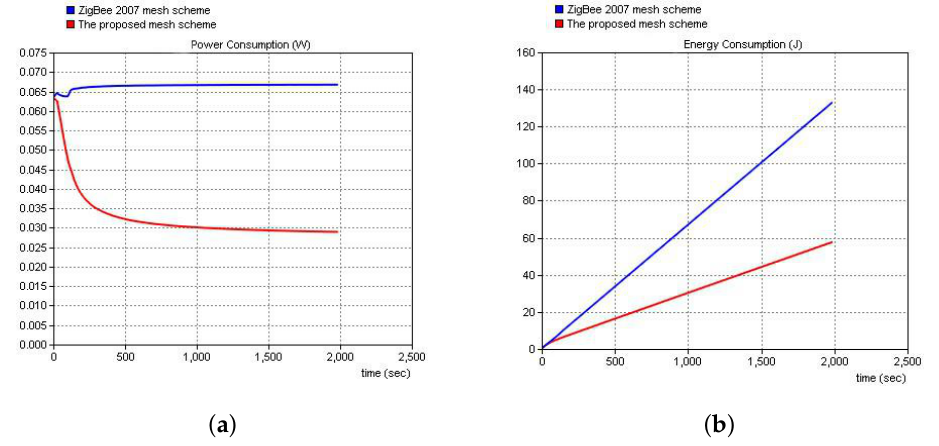
Figure 13. Comparisons of the networking power and energy consumption for the proposed solution and the ZigBee 2007 solution. ( a ) Power. ( b ) Energy.